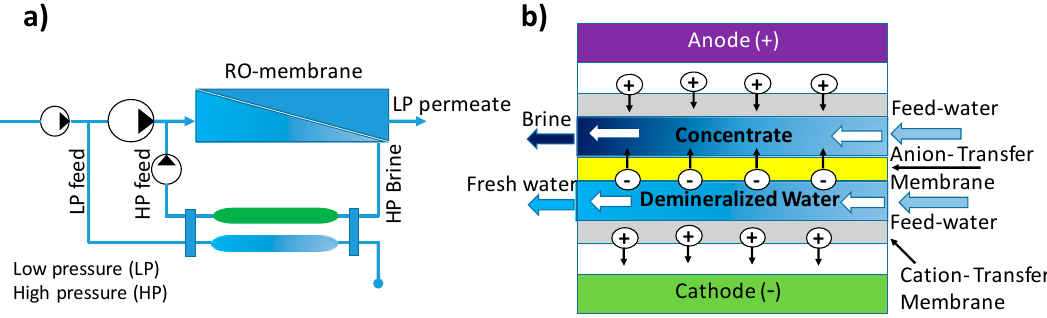
Figure 4. Typical scheme of membrane-based desalination modules; ( a ) reverse osmosis (RO), ( b ) electrodialysis (ED).